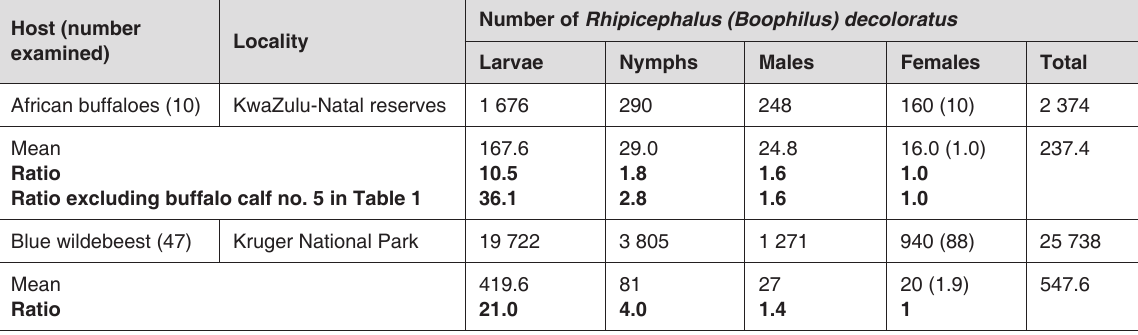
TABLE 4 Numbers of Rhipicephalus (Boophilus) decoloratus collected from African buffaloes and blue